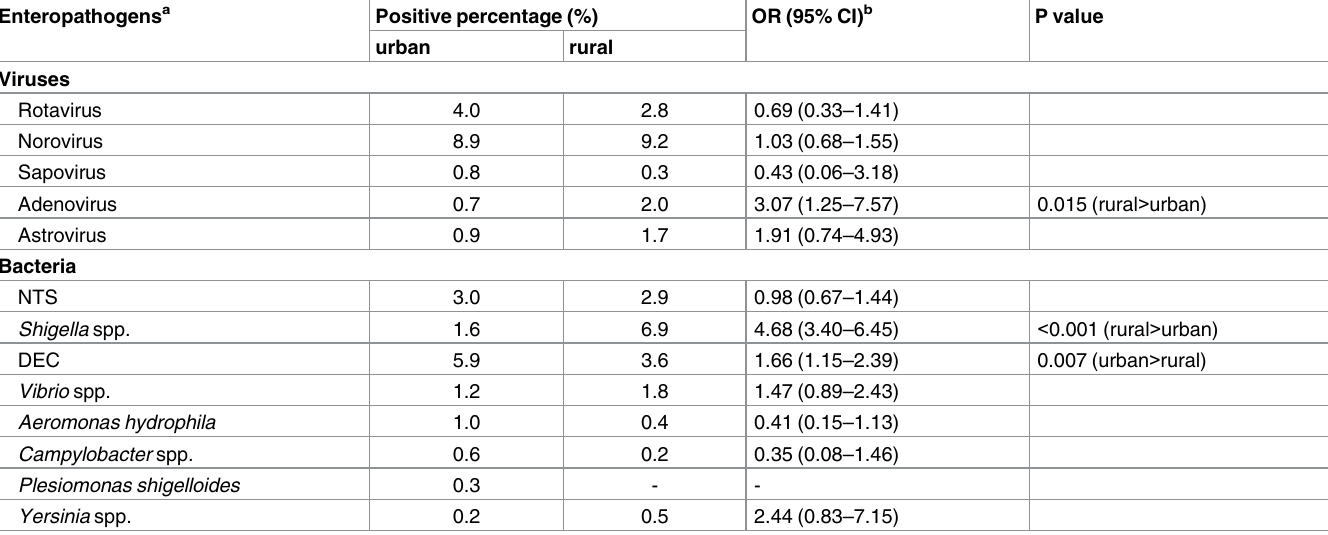
Table 3. Positive proportion of enteropathogens detected in urban and rural patients in China,